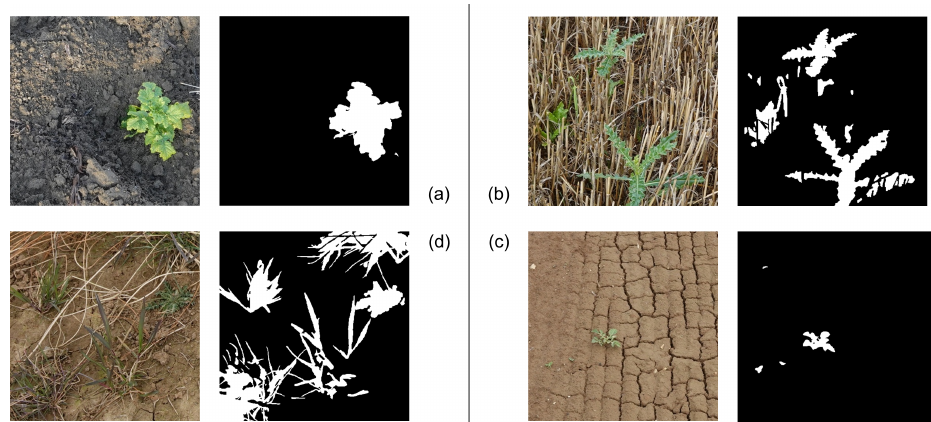
Figure 1. Random sample of 4 images and their annotation masks, showing the variety of conditions in the database. Clockwise starting from top-left: Image ( a ) shows an image with a big, clearly green plant, on a bar granular soil. Image ( b ) presents another variety of plant surrounded by dry grass, leading to partial occlusion of the plants’ leaves, as is clearly apparent on the segmentation mask. Image ( c ) shows sparsely distributed small weeds on a crackled dry soil. Image ( d ) presents multiple weeds and broad-leaf plants on a bare residual